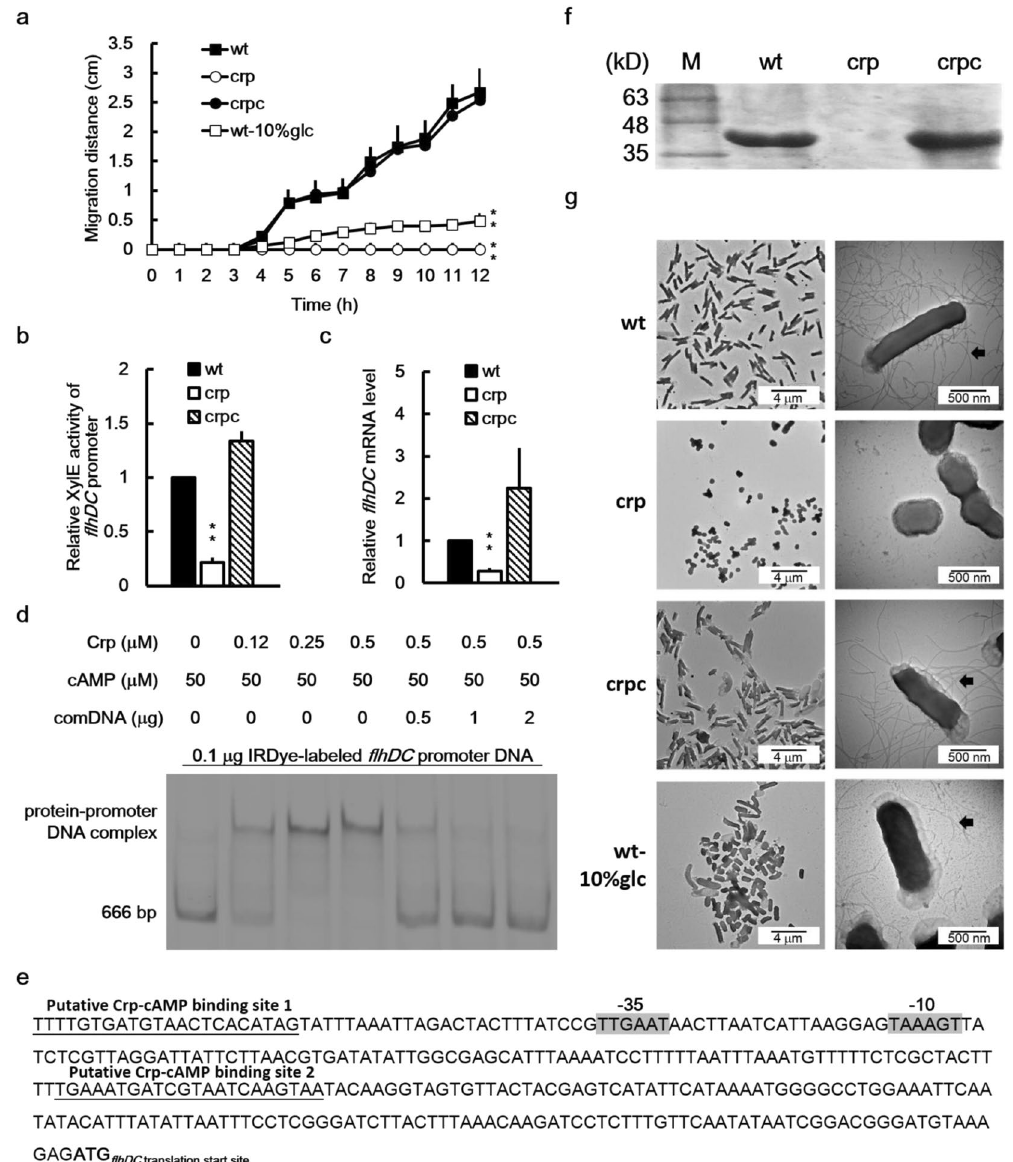
Figure 3. Loss of crp or high glucose reduced swarming, production of flagellin/flagella and flhDC expression in P . mirabilis . (a) Swarming migration of the wild-type in the absence or presence of 10% glucose, crp mutant and the crp -complemented strain. An aliquot (5 μ l) of overnight cultures was inoculated centrally onto the swarming plate. The migration distance was measured hourly after inoculation. The significant difference from wild-type is indicated with an asterisk at 12 h. ( b ) Promoter activities of flhDC in wild-type, crp mutant, and crp - complemented strain. The activities of XylE in the flhDC-xylE reporter plasmid-transformed bacterial strains were determined using the reporter assay at 7 h after incubation. The value obtained for the wild-type was set at 1. ( c ) The flhDC mRNA levels in the wild-type, crp mutant, and crp -complemented strain. The flhDC mRNA amounts were quantified using real-time RT-PCR at 7 h after incubation. The value obtained for the wild-type was set at 1. In ( a ),( b ) or ( c ), the data represent the averages and standard deviations of three independent experiments. Significant difference from the wild-type is indicated with an asterisk ( ** P < 0.01 by Student’s t test). ( d ) The binding of P . mirabilis Crp-cAMP to the flhDC promoter region revealed using an EMSA. IRDye- labeled DNA fragments (0.1 μ g) of the flhDC promoter region (666 bp) obtained by PCR were incubated with the purified His-tagged Crp (0–0.5 μ M) in the presence of cAMP. The protein-DNA complex was resolved on a 5% non-denaturing polyacrylamide gel and the gel image was obtained by the quantitative infrared fluorescent imaging system. The unlabeled flhDC promoter DNA acted as a competitor to verify the binding specificity. comDNA, competitive DNA fragments. ( e ) A diagram showing the Crp-cAMP binding sites upstream of flhDC gene. The putative Crp-cAMP binding sequences are underlined and the putative − 10 and − 35 promoter sequences of sigma 70 are shadowed. ( f ) The flagellin levels of wild-type, crp mutant and crp -complemented strain. Flagellin levels were examined after seeding on the swarming plates for 4 h by the SDS-PAGE. The band of flagellin is 40 kD. M, molecular weight marker. ( g ) TEM pictures of wild-type in the absence or presence